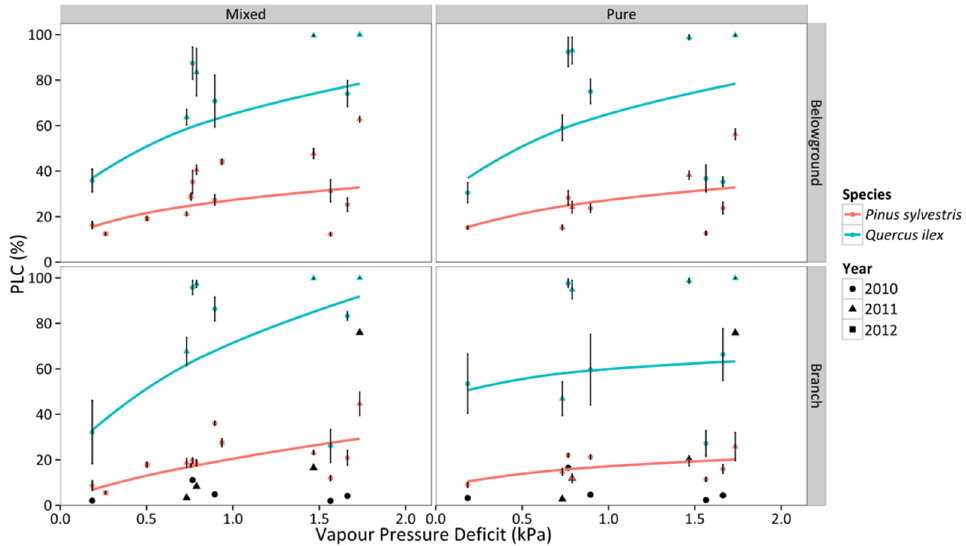
Figure 9. Responses of percentage loss of conductivity (PLC) to daytime averages of VPD in two different stand types throughout three consecutive years. Average values for P. sylvestris and Q. ilex trees are shown. Error bars indicate ±1 SE. The regressions for the different combinations of species and stand type according to best-fitting models are also depicted ( cf. Table S4). Black symbols represent the PLC values obtained following the vulnerability curves from Martin-StPaul et al. [48] for Q. ilex